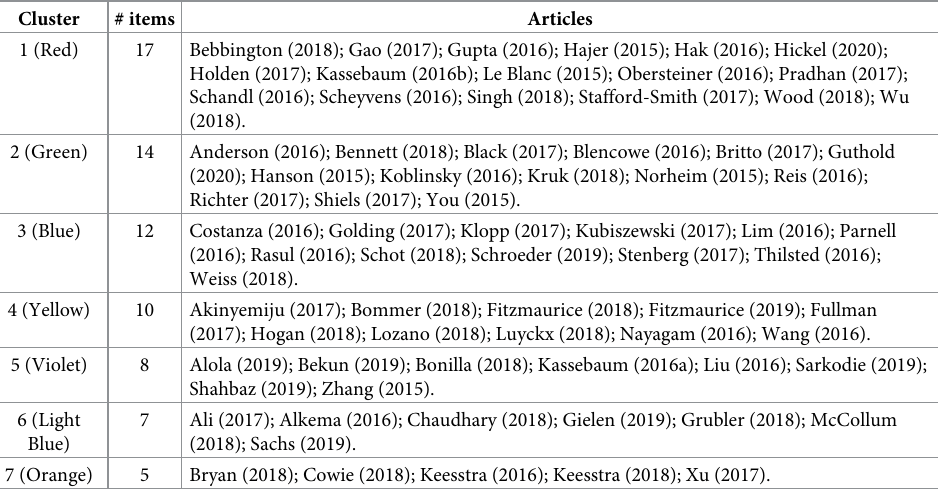
Table 6. Articles according to coupling-citation